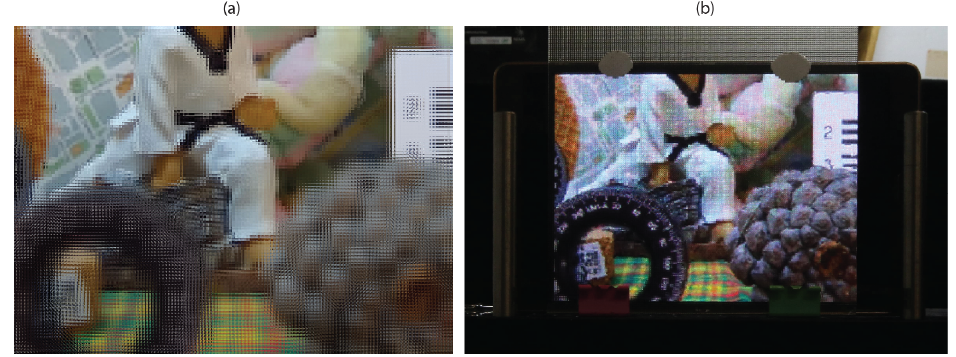
Figure 9. Field of view selection: ( a ) The integral image obtained with the same reference plane and pitch of Figure 7d, with half its field of view ( z = 2). ( b ) Projection in 3D InI